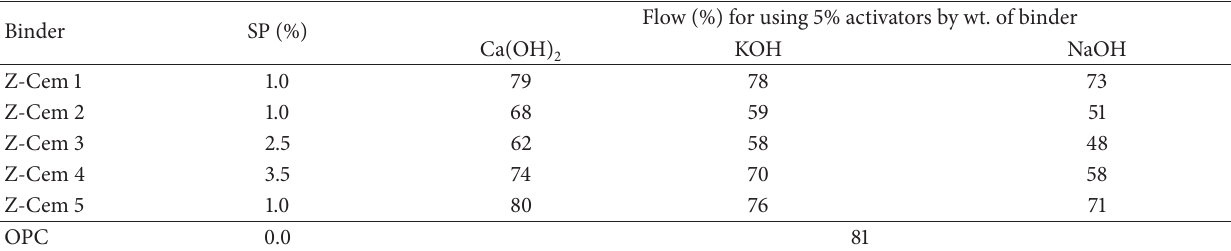
Table 5: Flow and SP requirements for 0.55 W/B ratio with Sa/B ratio of